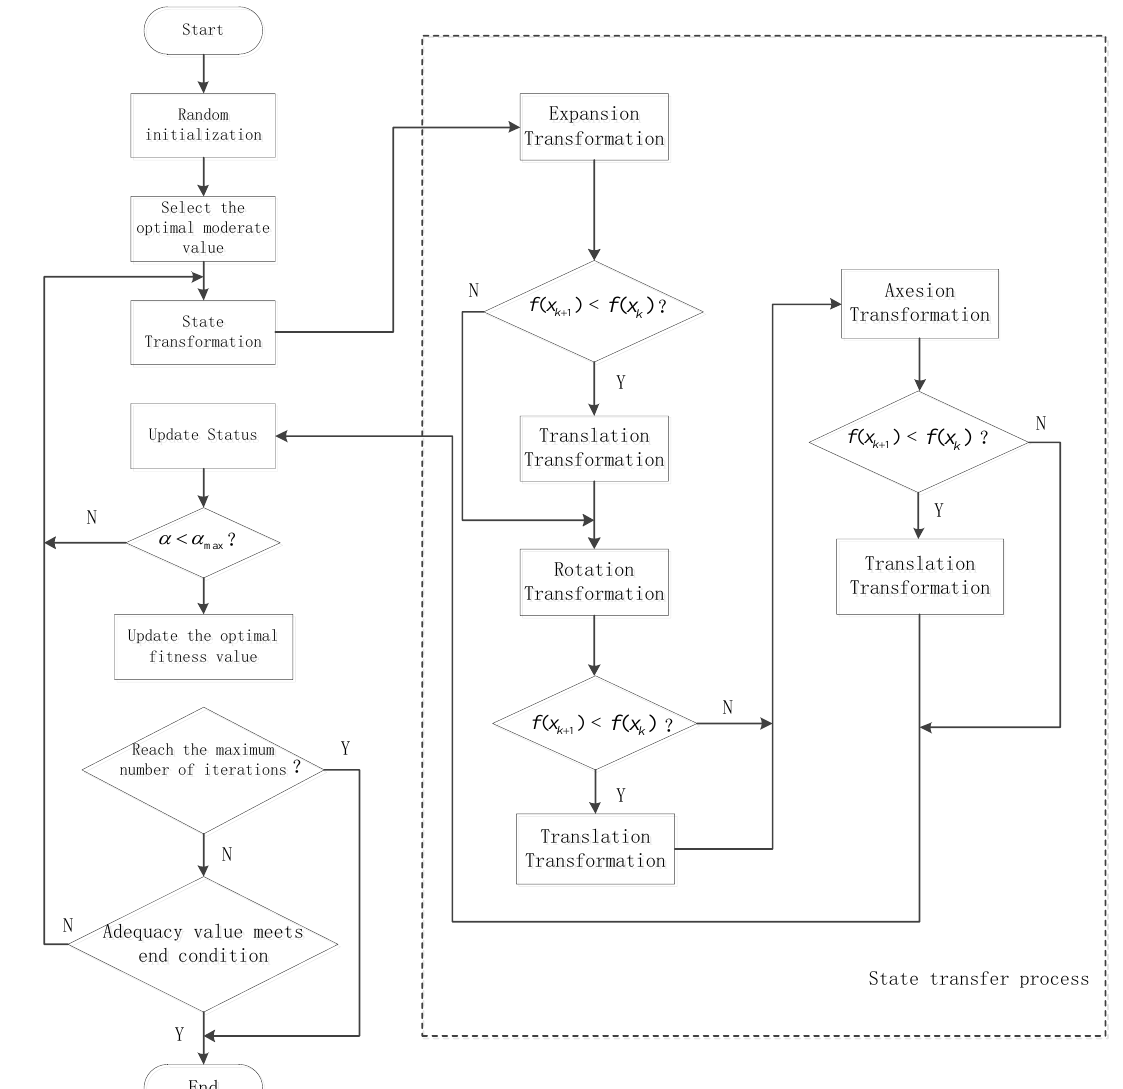
Figure 4. T he schematic of cell voltage optimization flow-based STA. Figure 4. The schematic of cell voltage optimization flow-based